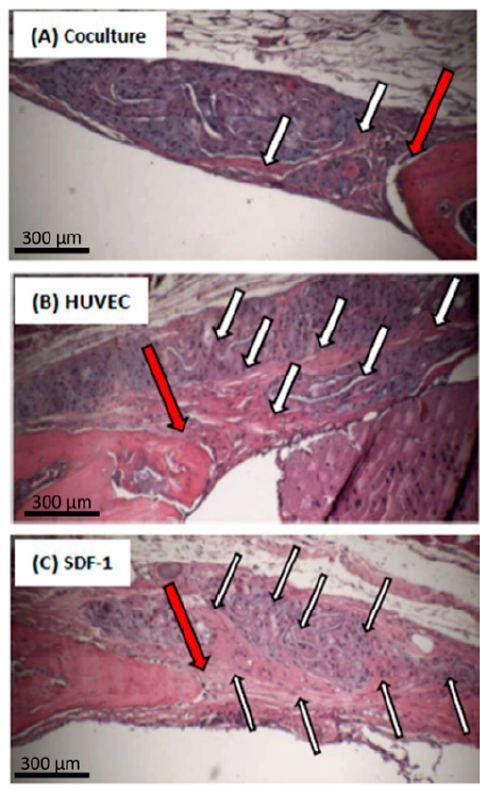
Figure 4. Hematoxylin-eosin (HE) staining of the calvarial defect region: zoom into the transitional region between native bone and new formed bone in the groups co-culture ( A ); monoculture of endothelial cells ( B ) and SDF-1 ( C ). Red Arrows indicate the transitional regions, black/white arrows indicate active cells and areas of new ossification.